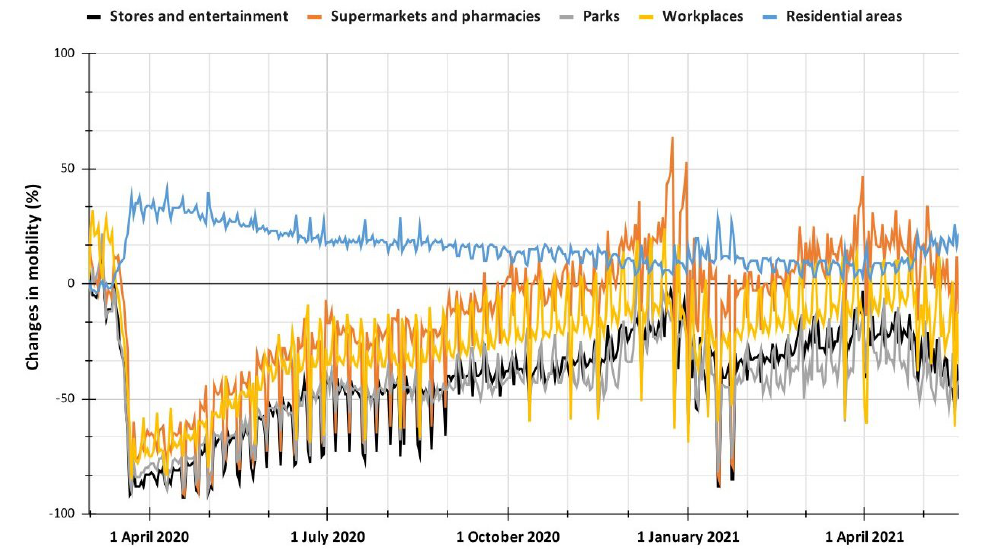
Figure 9. Changes in mobility as reported by Google for the period from 1 March 2020, to 19 May